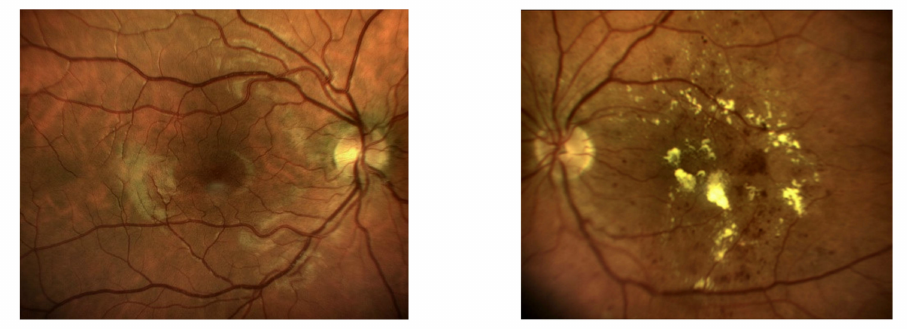
Figure 1. Diagnostic images of fundus without pathologies ( left ) and with pathology ( right